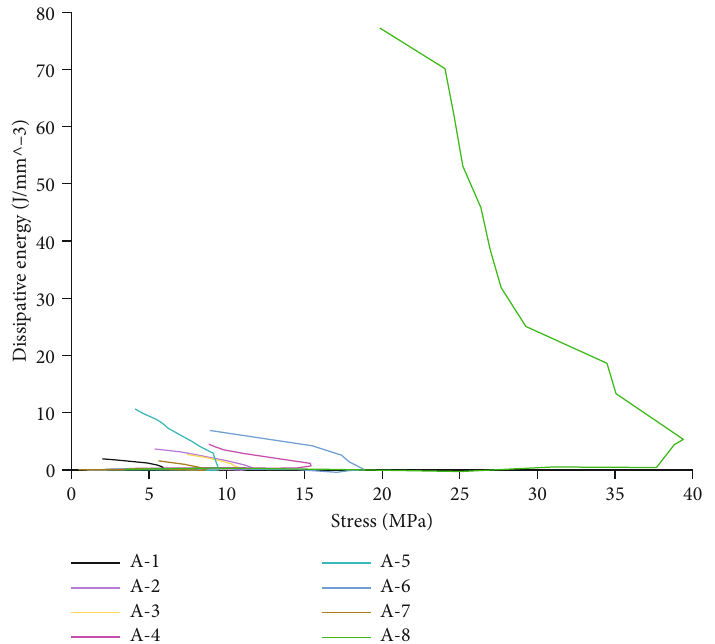
Figure 8: Evolution curve of dissipated energy and axial stress of